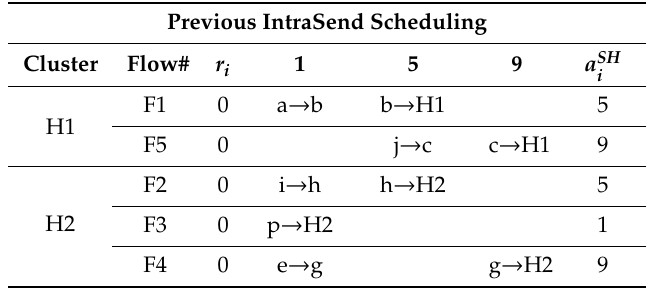
Table 1. Results of previous scheme IntraSend scheduling of Figure 2.